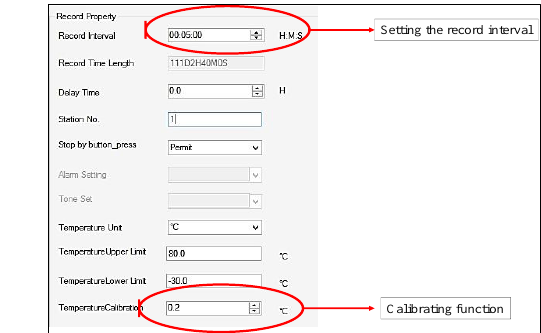
Figure 3. RC-5 Temperature Data Logger Figure 4. Calibrating and setting the time interval parameter